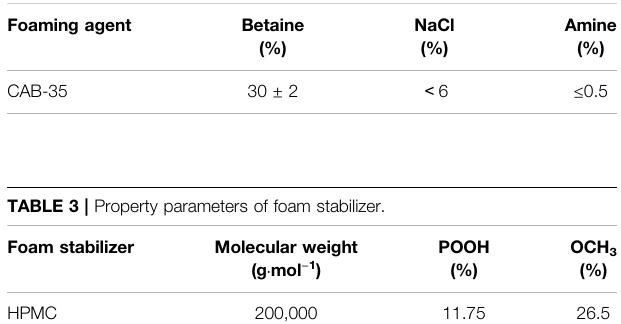
TABLE 2 | Property parameters of foaming agent.